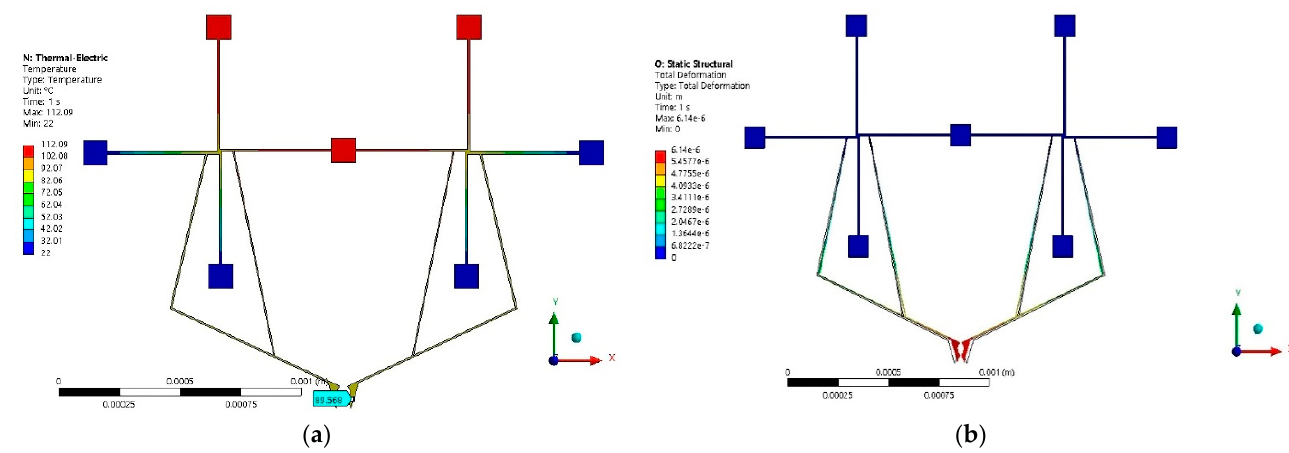
Figure 10. ( a ) Force and displacement parameterization, and ( b ) left section of microgripper Model 1, with the arm locations on the rotary microactuator.